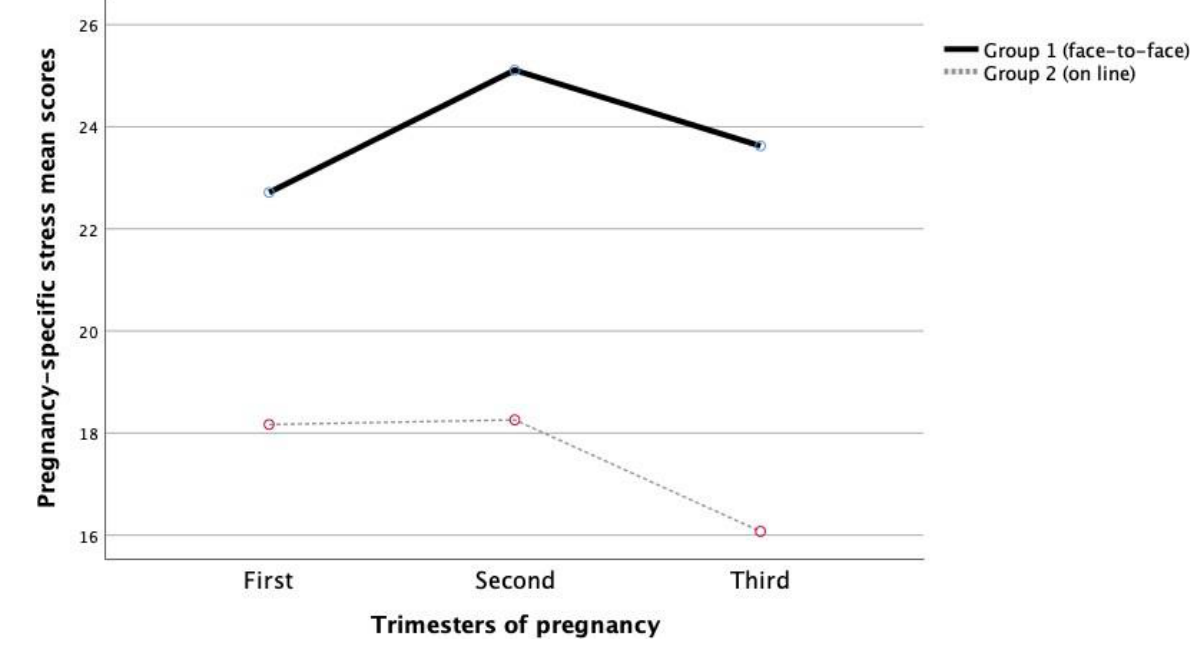
Figure 2. Cross-sectional assessment of pregnancy-specific stress in the first, second, and third trimester (face-to-face versus online recruitment).